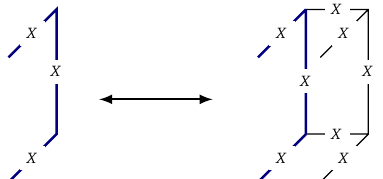
Figure 11: Adjoint action of the circuit on stabilizers of the two systems converts the plaquette term at the rough boundary of the toric code to the cube term in the X-cube model and vice versa. As in Fig. 10, bold (blue) lines correspond to edges of the new